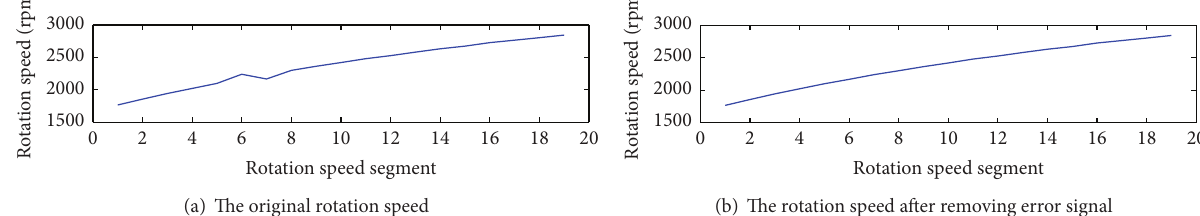
Figure 2: Speed curve of acceleration process.